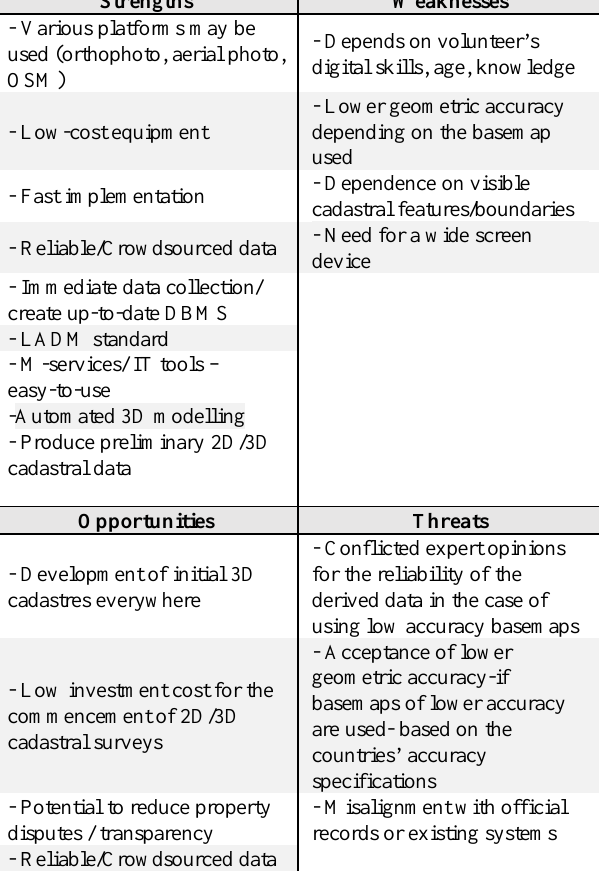
Table 1. SWOT results on the proposed crowdsourced